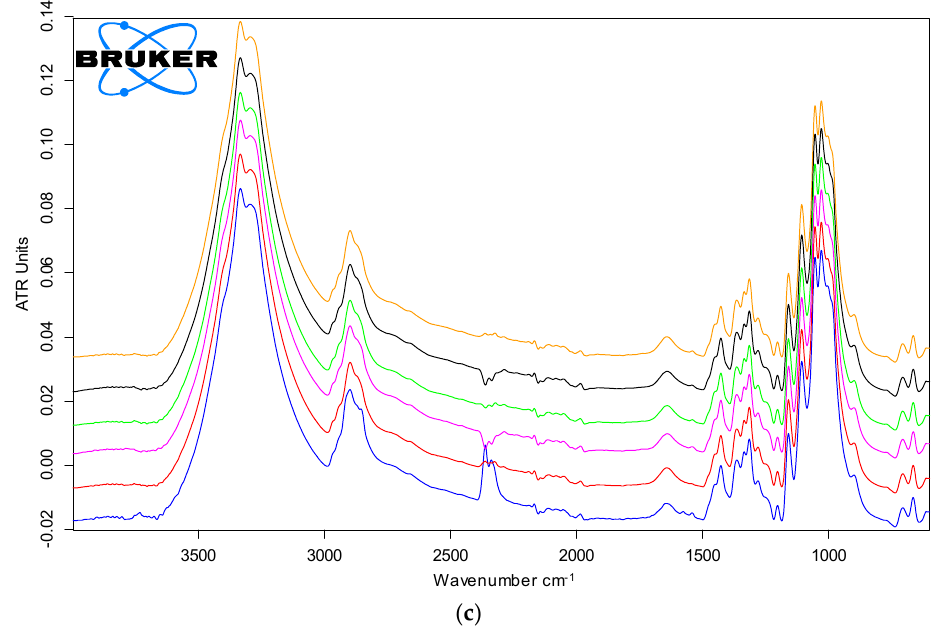
Figure 1. FTIR-ATR spectra: ( a ) unimpregnated and unirradiated cotton material reference (blue line); impregnated with Ag/C and unirradiated (red line—control 0 kGy); and impregnated and irradiated at 5 kGy in a dry state (purple line) and a wet state (green line) and 20 kGy in a dry state (black line) and a wet state (orange line); ( b ) unimpregnated and unirradiated cotton material reference (blue line); impregnated with Ag/PVP and unirradiated (control 0 kGy—red line); and impregnated and irradiated at 5 kGy in a dry state (purple line) and a wet state (green line) and 20 kGy in a dry state (black line) and a wet state (orange line); ( c ) unimpregnated and unirradiated cotton material reference (blue line); impregnated with ZnO/PVP and unirradiated control 0 kGy (red line); and irradiated at 5 kGy in a dry state (purple line) and a wet state (green line) and 20 kGy in a dry state (black line) and a wet state (orange line). Table 1. FTIR data of cotton cellulose.